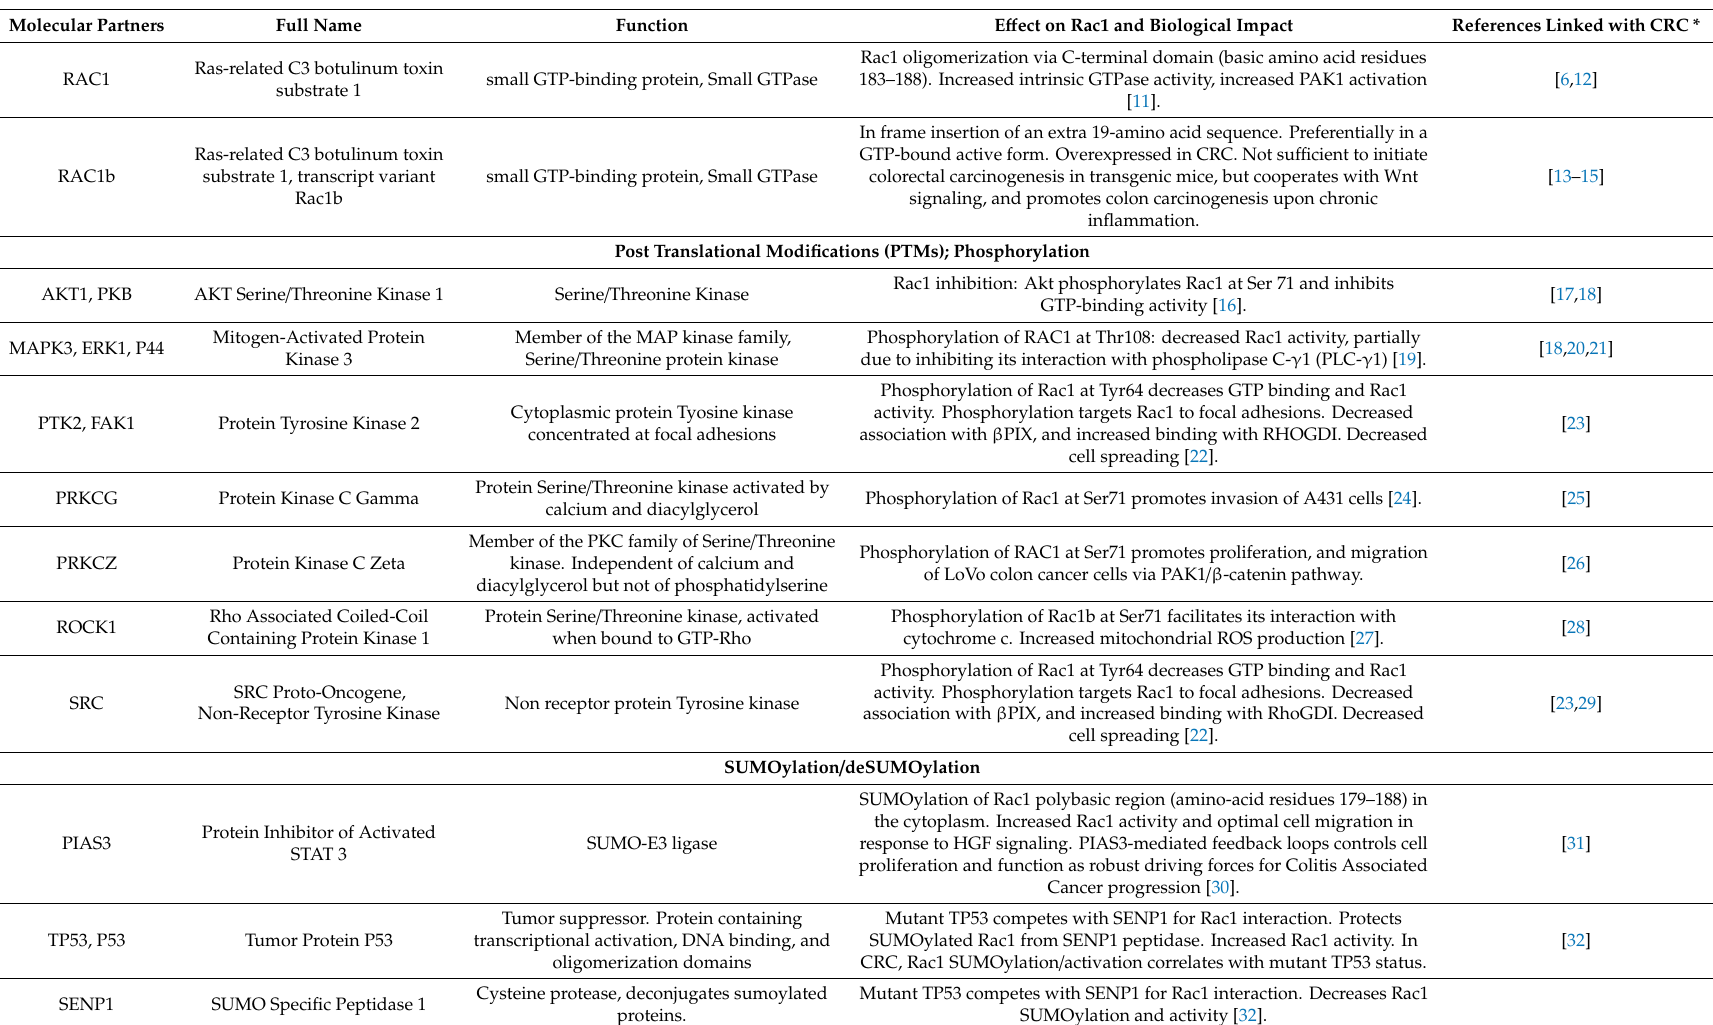
Table 1. Post translational modifications (PTMs) and functional